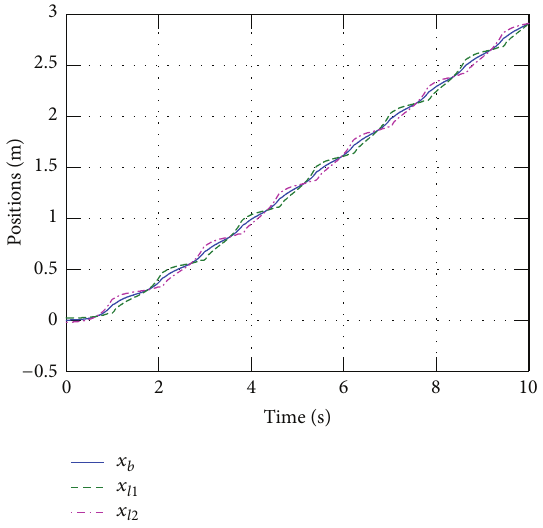
0.8 0 Figure 9: Rotational angles of the legs ( 𝜃 𝑙𝑗 : leg 𝑗 ). The quadruped robot moves the supporting leg in the negative direction imme- diately before switching the supporting leg to increase the robot’s kinetic energy. The legs return to its initial position immediately after